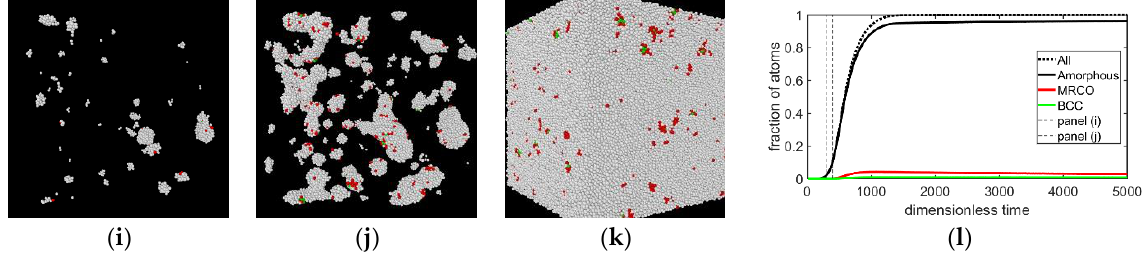
Figure 3. Nucleation and growth in the sHPFC model after instantaneous quenching to reduced temperatures ε = 0.200 (top row), 0.202 (central row), and 0.204 (bottom row). Coloring indicates the magnitude of the average bond order pa- rameter q 6 . White (amorphous): q 6 < 0.28; red (MRCO): 0.28 < q 6 < 0.4; green (bcc): q 6 > 0.4. The deeper the quench, the larger the nucleation rate for the amorphous phase, and the smaller the bcc fraction forming during solidification. The bcc phase forms via heterogeneous nucleation on the surface of amorphous globules. Instances for the snapshots—upper row: t = ( a ) 800, ( b ) 1700, and ( c ) 5900; central row: t = ( e ) 600, ( f ) 900, ( g ) 7700; bottom row: t = ( i ) 300, ( j ) 400, and ( k ) 7700. Panels ( d ), ( h ), and ( l ) show the time dependence of phase fractions. The incubation time is not shown.